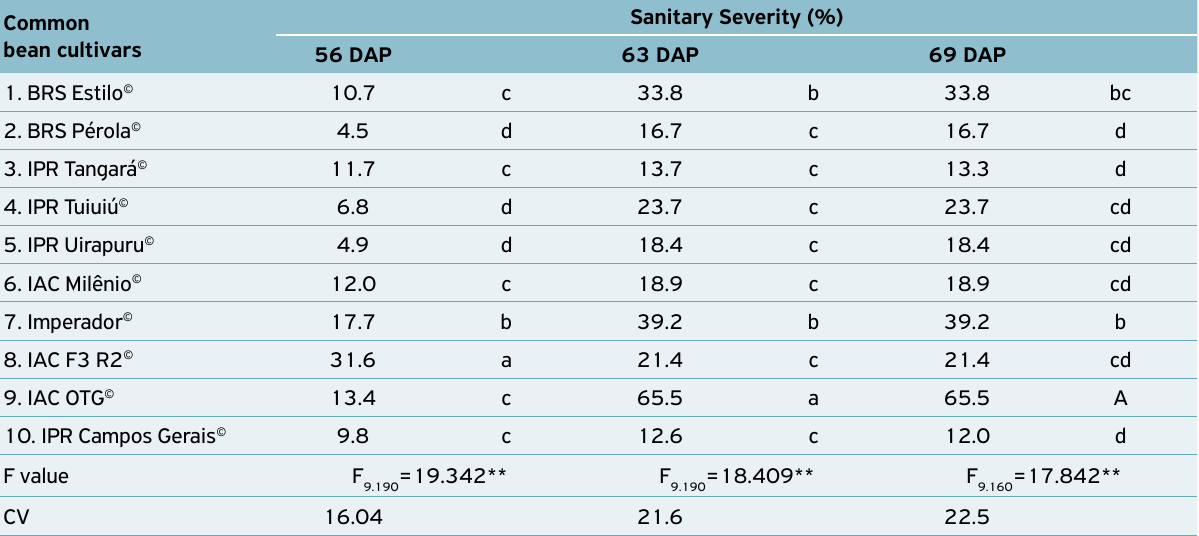
Table 2. Transform average by (x+10) of sanitary severity in DAP, in different common bean cultivars cultivated in 2015-2016.